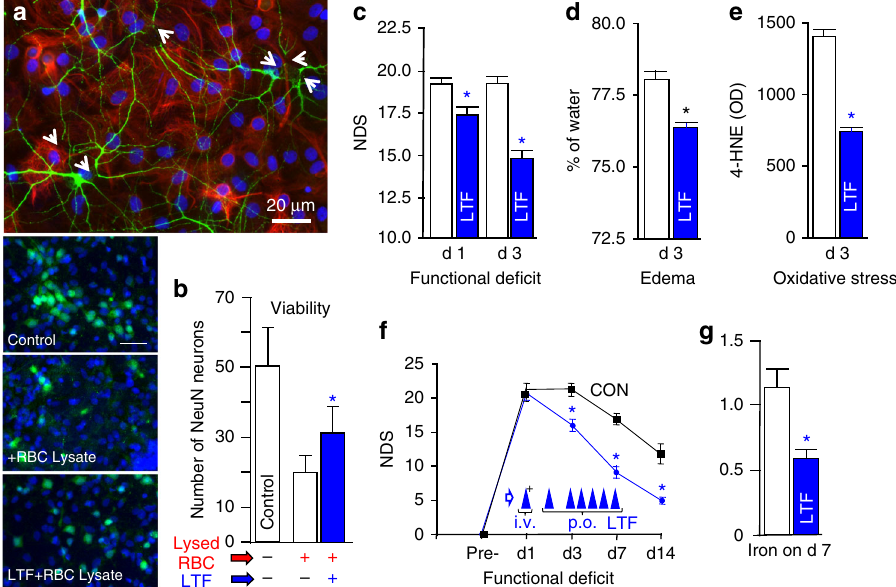
Fig. 6 Neuroprotective effect of recombinant LTF in vitro ( a , b ) and in a clinically relevant rat ( c – e ) and mouse ( f , g ) model of ICH. a Representative immuno fl uorescence of MAP2 + -neurons ( green ) and GFAP + -astrocytes ( red ) in rat brain cortical neuron-glial co-cultures at 24 h after exposure to RBC lysate (an ICH-like injury in vitro), demonstrating that lysed RBCs are toxic to neurons. Arrows show the swollen soma and broken dendrites. Astrocytes are less prone to the injury. b Representative images ( left part of the panel) showing density (viability index) of NeuN + -neurons ( green ) in the rat neuron-glial co-cultures at 24 h after the exposure to lysed RBC in the presence or absence of rLTF, (5 μ g/ml), which was added to the co-culture at 30 min prior to the insult (adding lysed RBCs). The nuclei were labeled with DAPI ( blue ). Scale bar = 50 µ m. And a bar graph of NeuN + -neuron numbers at a 10× fi eld. Data were mean ± SEM ( n = 15). * p ≤ 0.05 from all other groups; established using one-way ANOVA followed by Newman – Keuls post-test. c – e rLTF reduces ICH-mediated brain damage in rats after ICH. Rats were treated with rLTF (5 mg/kg, i.v. at 30 min after ICH plus 2.5 mg/kg p.o., at 24 and 48 h) and assessed for c NDS (a composite score for footfault, circling, wire, postural fl exing, and forward placing test) at days 1 and 3 ( n = 10), d oxidative burden (4-HNE; index of lipid peroxidation) at day 3 ( n = 5), and e brain edema (% of water content) at day 3 ( n = 5). f , g Recombinant mouse LTF, improves outcome after ICH in mice that were treated as late as 24 h after ICH (5 mg/kg, i.v. at 24 h after ICH plus 2.5 mg/kg p.o., on day 2 – 7) as determined